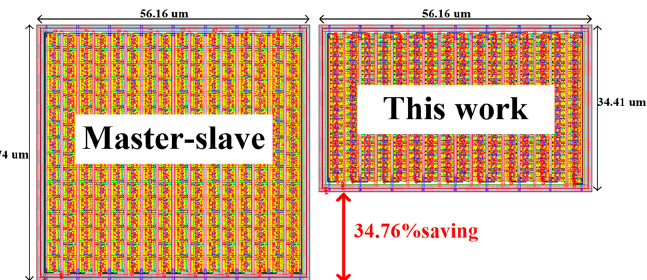
Figure 8. 256-bit shift register, proposed CLSR scheme and the conventional master–slave latch architecture layout.